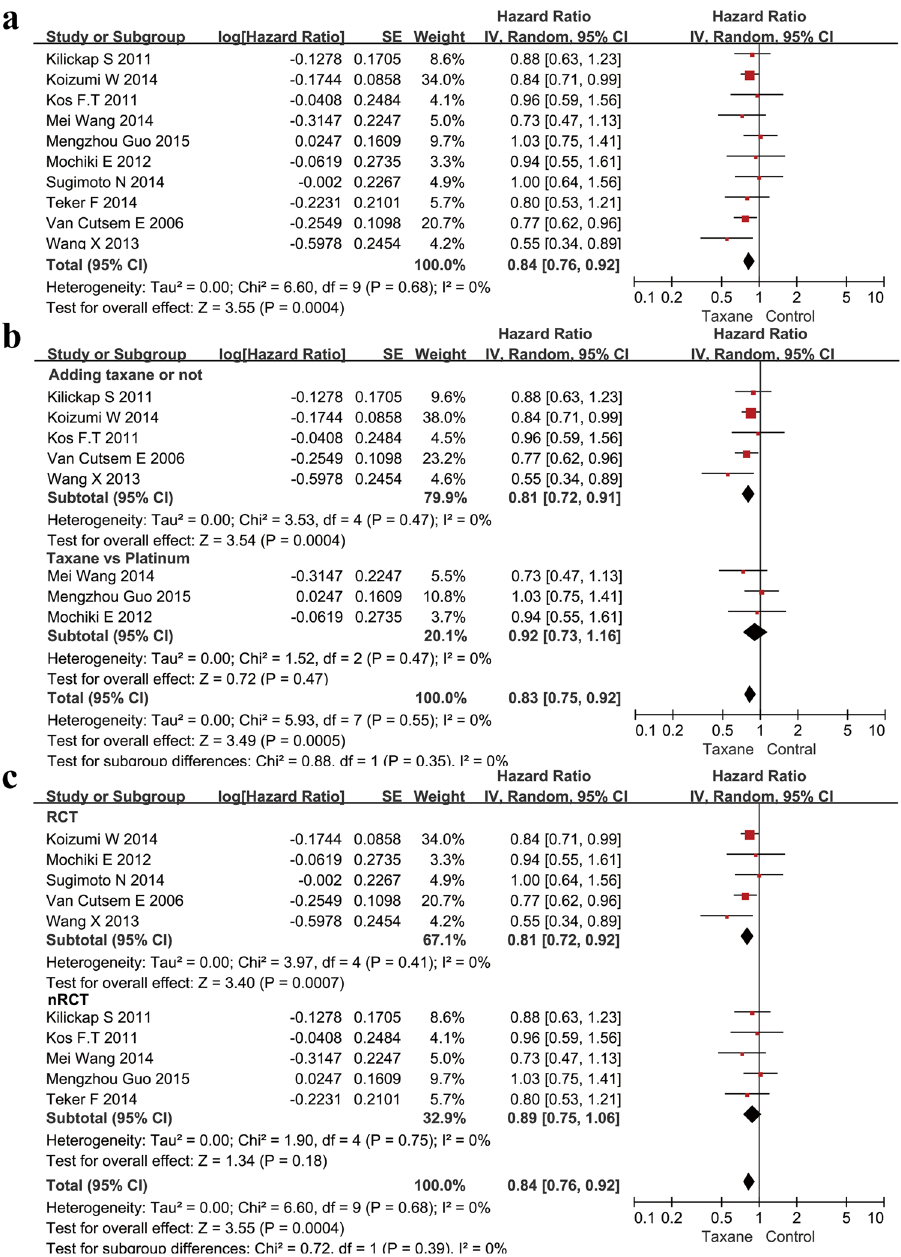
Figure 3. Meta-analysis of the overall survival (OS). ( a ) Forest plots of the hazard ratio (HR) for the OS comparing Taxane with control. ( b ) Subgroup analysis between the adding and replacing groups of the OS. ( c ) Subgroup analysis between the RCT and nRCT groups of the